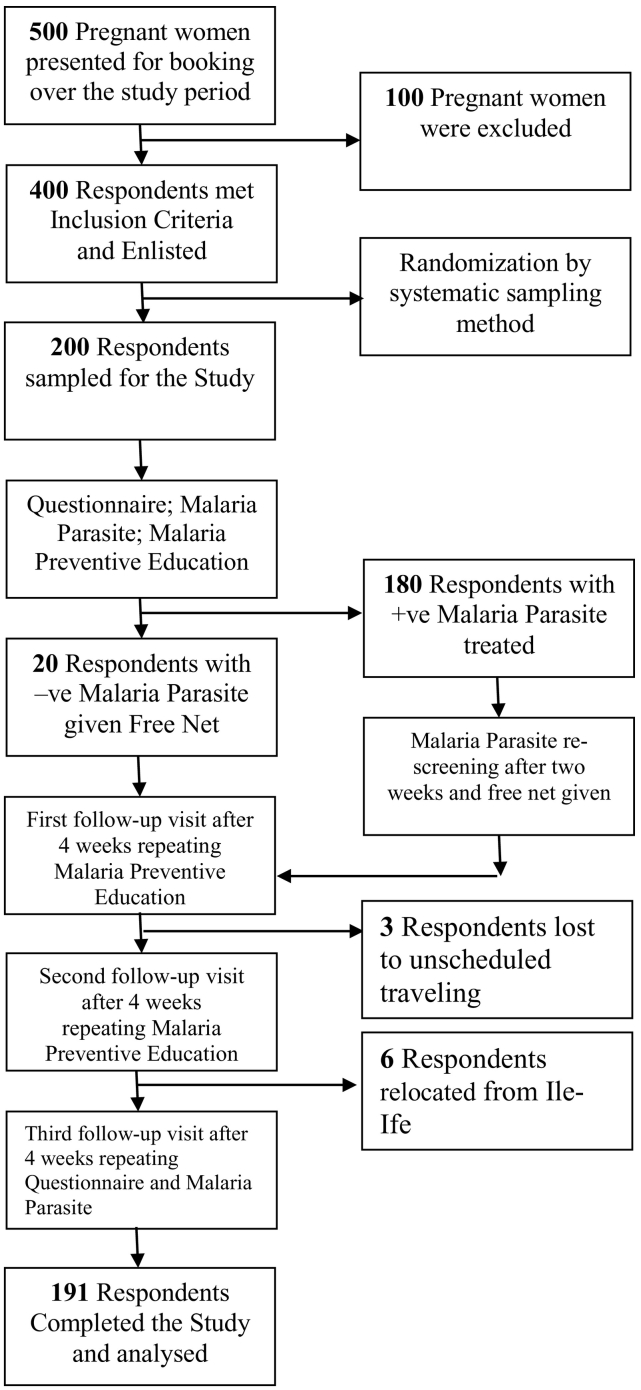
The Study Flow Chart.